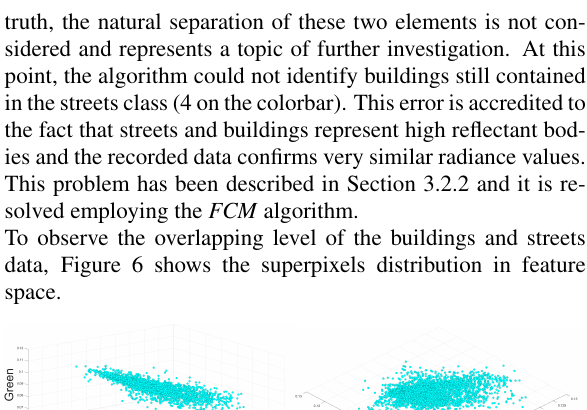
Figure 5. Preliminary labeled image for Greding after hierarchical tree division.